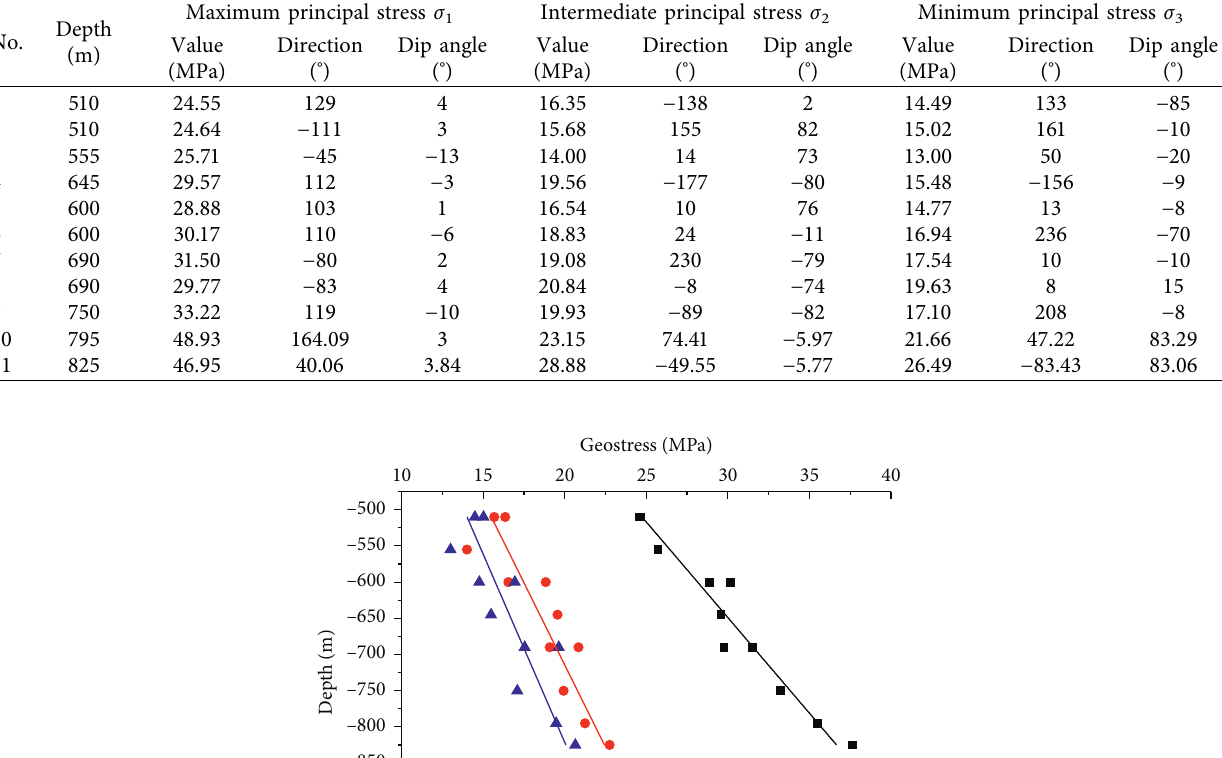
Table 1: Geostress data from in situ monitoring.